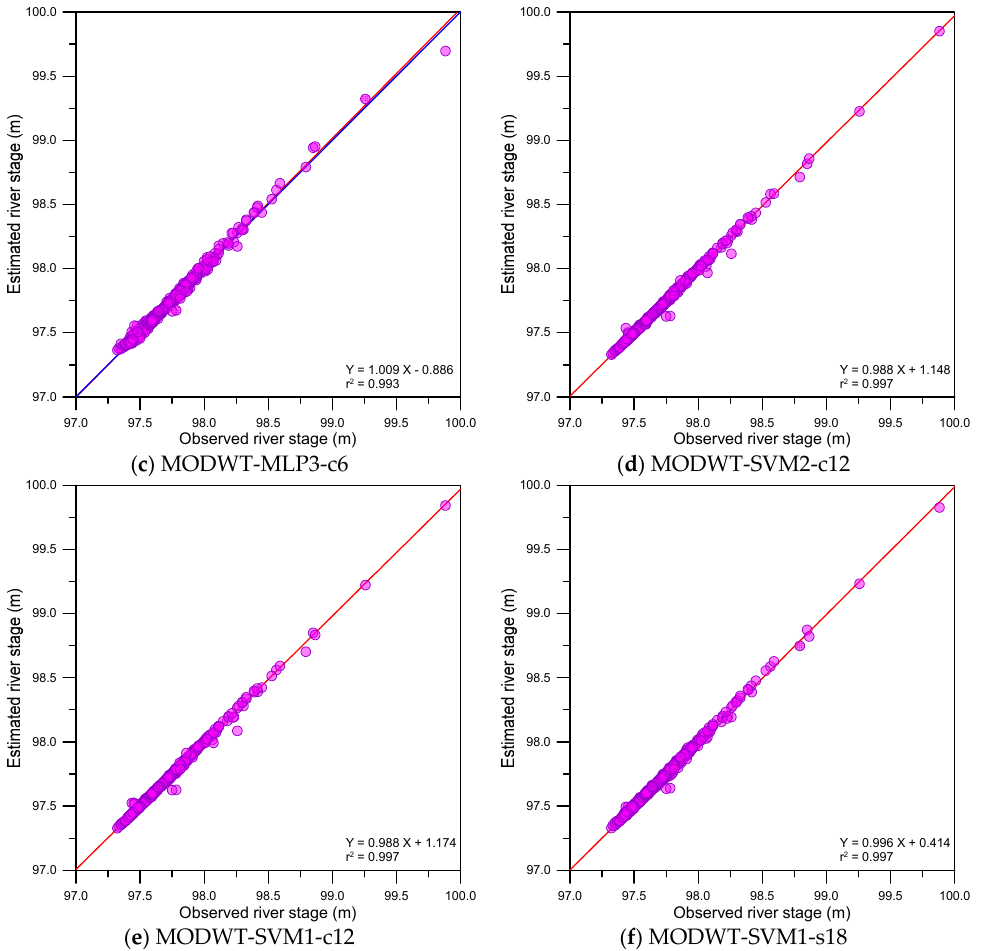
Figure 11. Scatter plots for the MODWT-based models.